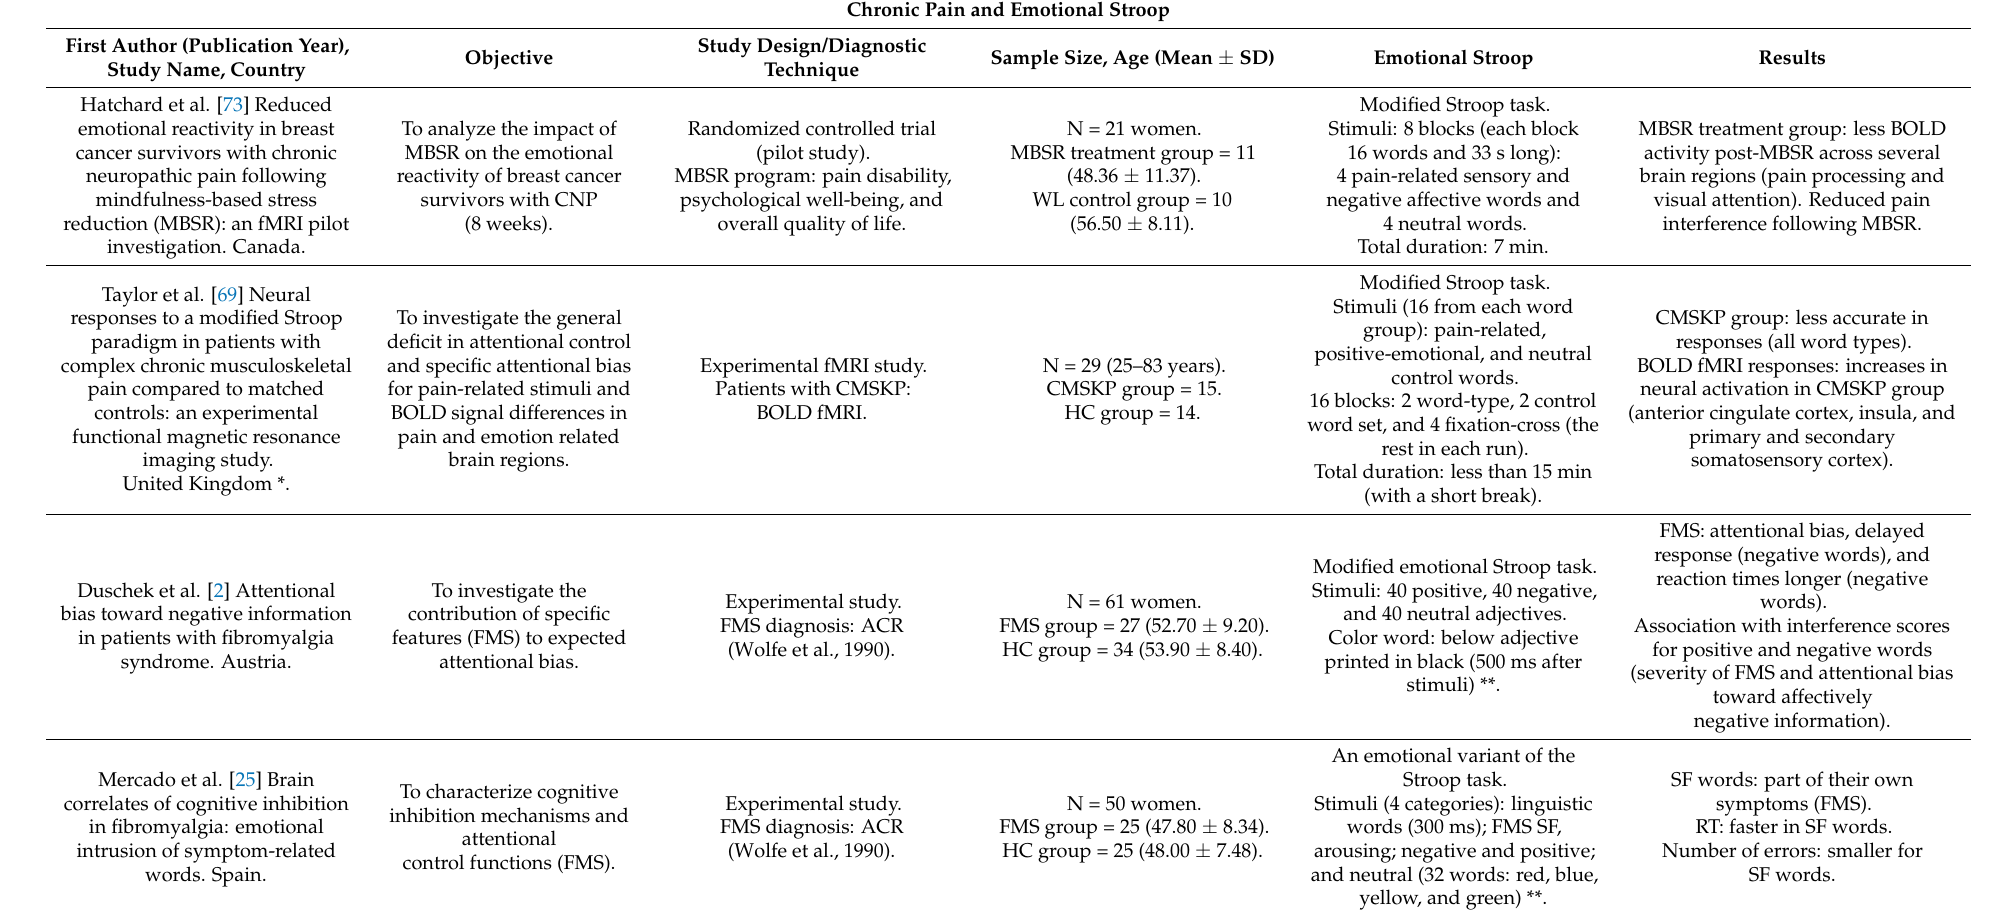
Table 1. Characteristics of selected studies on Chronic Pain and Emotional